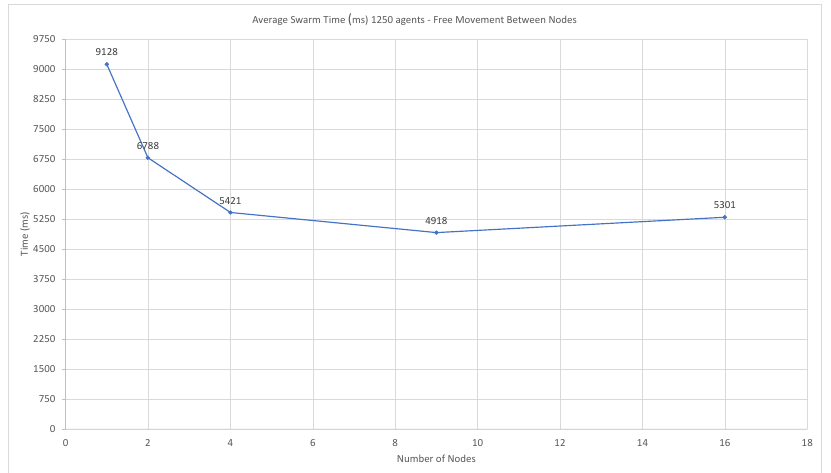
Figure 10. Swarm timing (ms) for 1250 agents on 1, 2, 4, 9, and 16 nodes, using data from Section 2.2.1 with cellular morphology features, with agents moving freely between nodes.